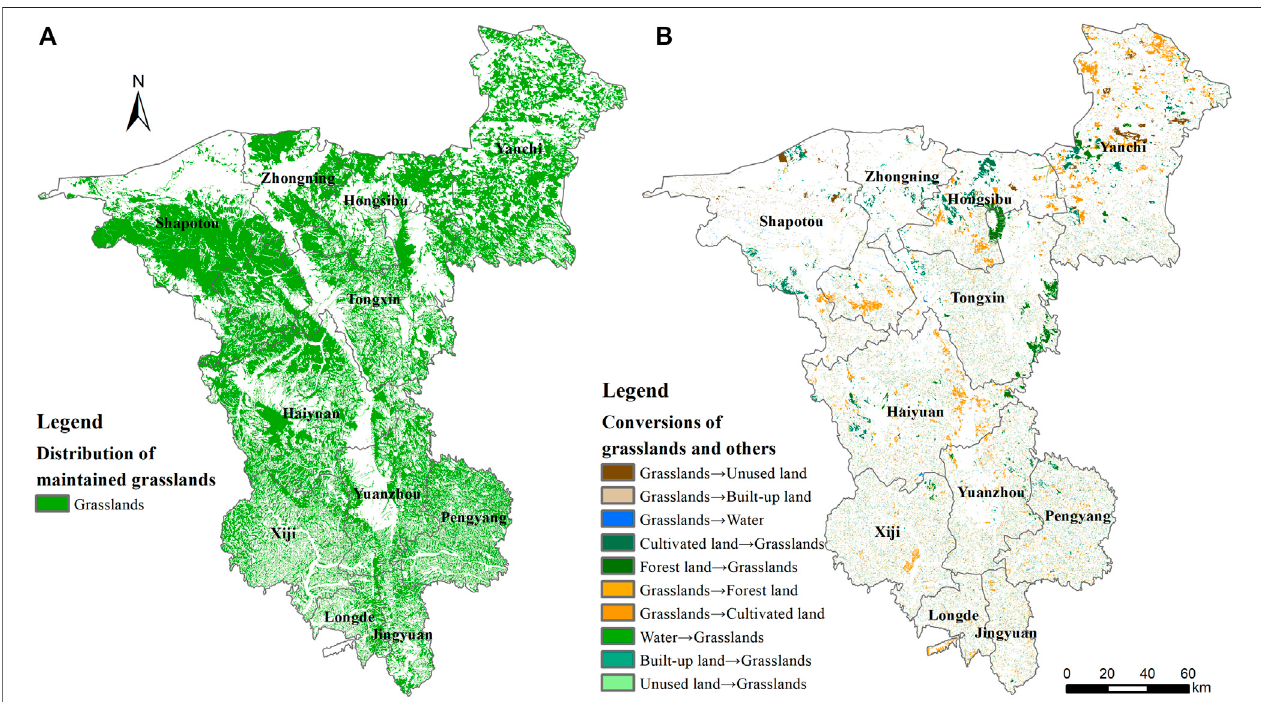
FIGURE 3 | Distribution of the grasslands maintained and their conversion with other land-use types from 2000 to 2018.